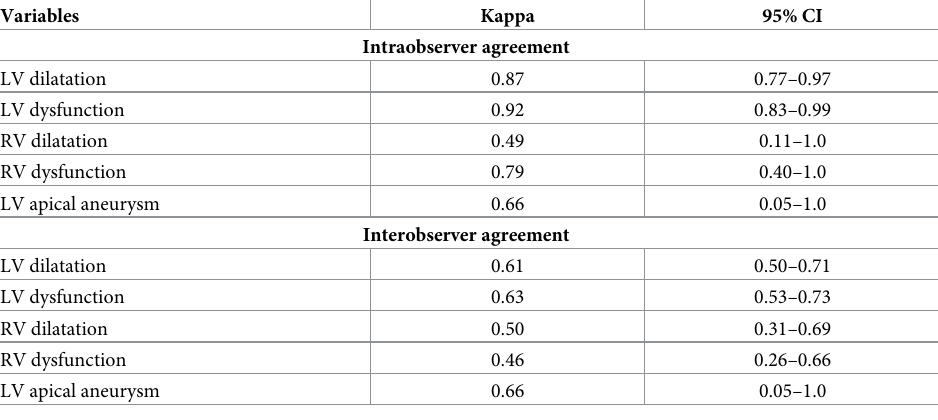
Table 5. Intraobserver agreement of FoCUS in patients with Chagas disease from the Sami-Trop